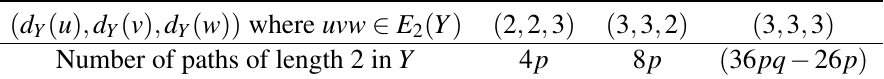
Table 4 Partition of paths of length 2 of the graph Y